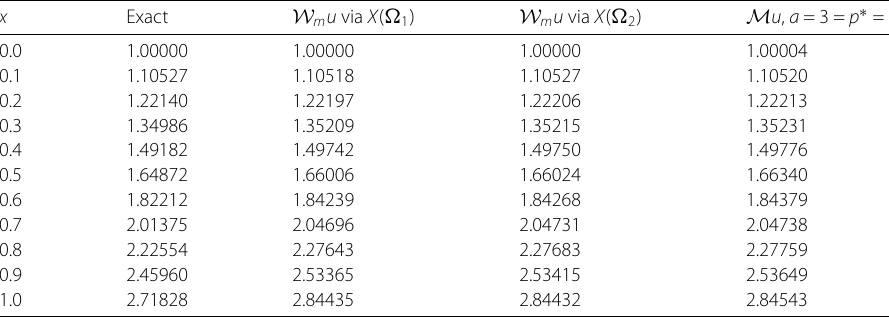
Table 1 Numerical results of Example 4.1 using the framelet systems X ( (cid:7) 1 ) and X ( (cid:7) 2 ) for m = 3 and λ = 3.25 0.0